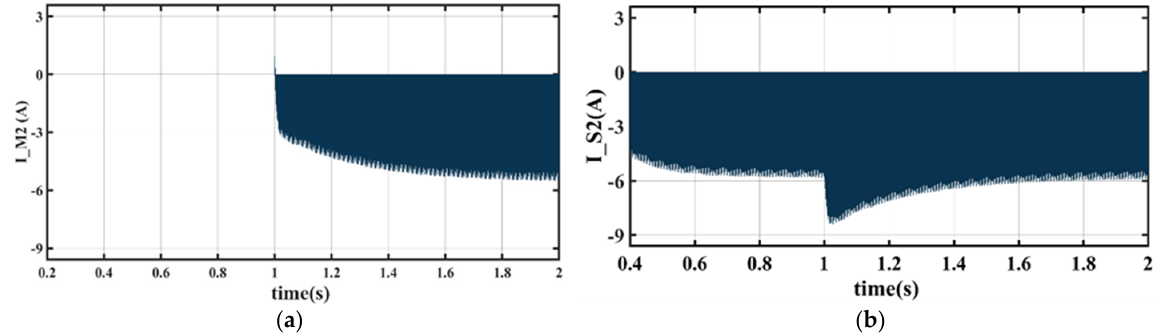
Figure 13. Simulation results for the proposed fault–tolerant topology with the proposed fault di- agnosis algorithm when an OCF occurs on switch S4 in reverse mode: ( a ) current of switch S2 ; ( b ) current of switch M2 .